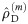
Simulation of quantitative traits from the HUMAN data.Simulation of quantitative traits with 5 (top left), 20 (top right), 100 (middle left), 2000 (middle right), 10000 (bottom left) and 50000 (bottom right) causal variants from the Asian individuals in the HUMAN data. The blue circles are the ρ^D(m) used to build the curve, and the red point is ρ^D(0). The blue line is the mean decay trend, with a shaded 95% confidence interval, and the dashed blue line is the linear interpolation provided by the ρ^L. The red squares labelled EUROPE, MIDDLE EAST, AMERICA, AFRICA and OCEANIA correspond to the ρ^P for the individuals from those continents, and the red brackets are the respective 95% confidence intervals.